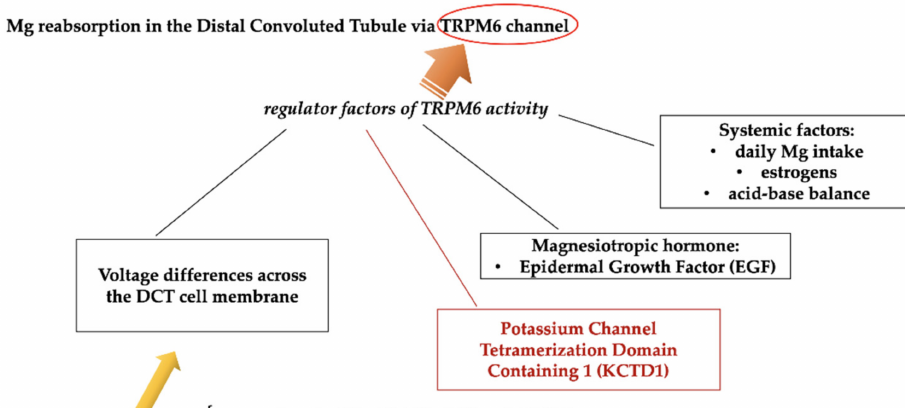
Figure 3. Magnesium homeostasis ([27]).